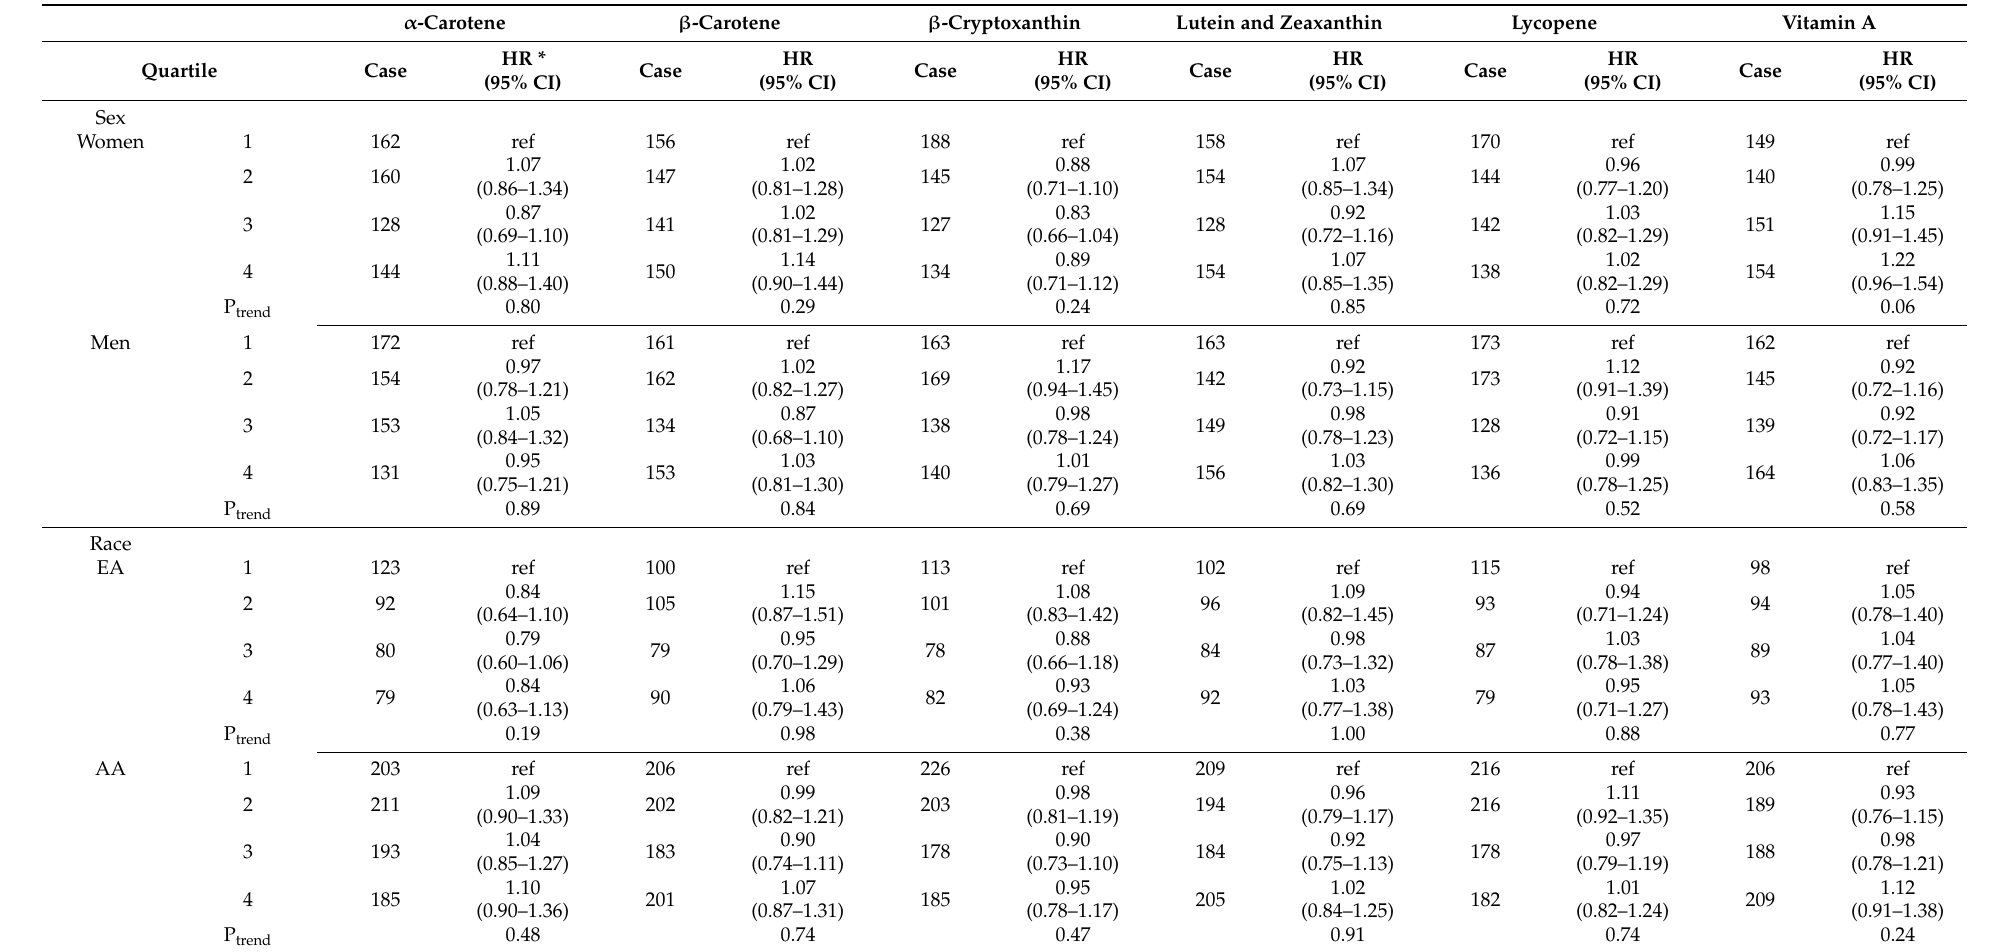
Table 3. Associations of dietary intakes of carotenoids and vitamin A with lung cancer risk by race and sex, SCCS. α -Carotene β -Carotene β -Cryptoxanthin Lutein and Zeaxanthin Lycopene Vitamin